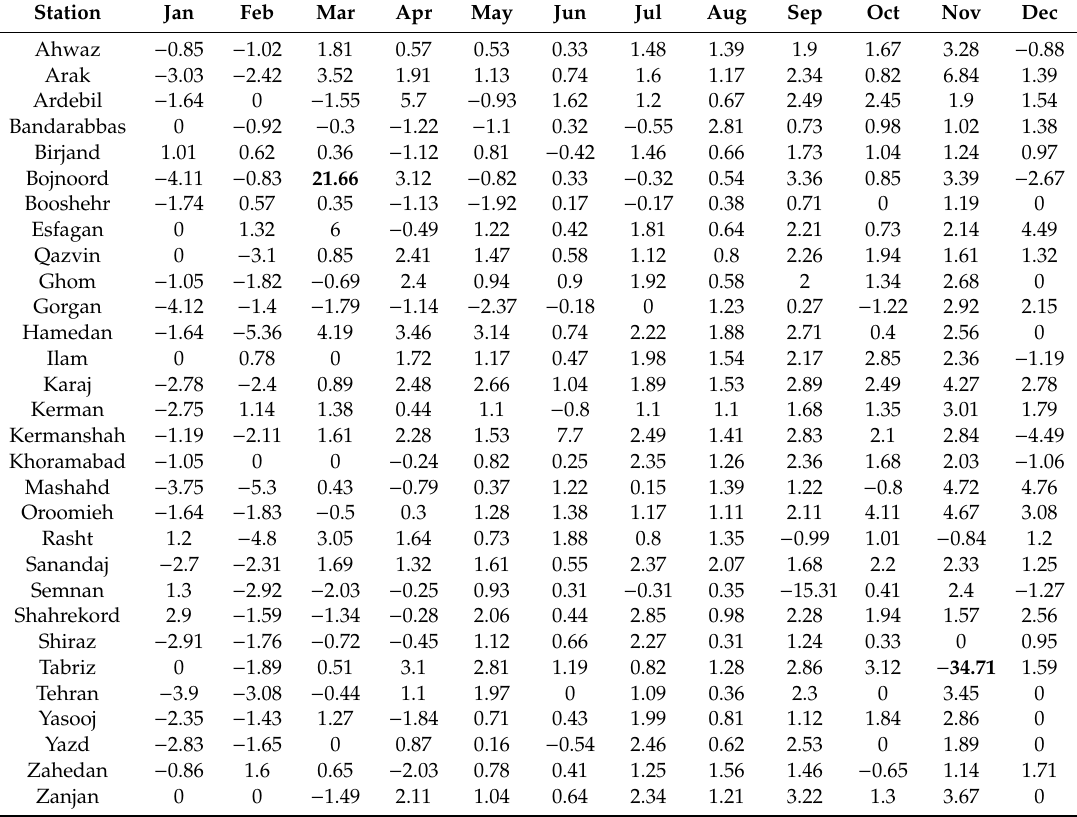
Table 3. Change percentages of the ET 0 predicted for the period from 2011 to 2045 under B1 scenario.